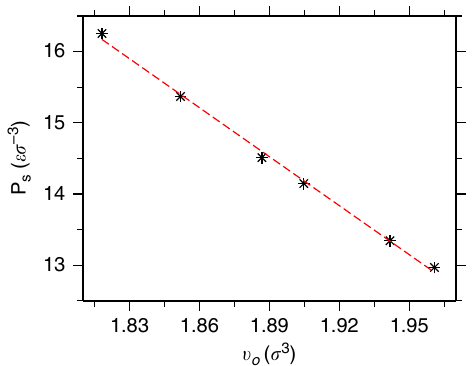
Fig. 5 Pressure change in bare solvent with the change in molar volume. Variation of pressure P s with change in molar volume v for a bare solvent ¼ R = R x ¼ 0 ð Þ is g g g c